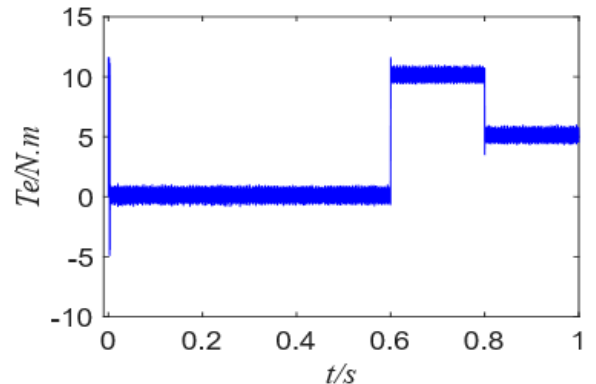
Figure 11. Torque of FCS-MPCC.